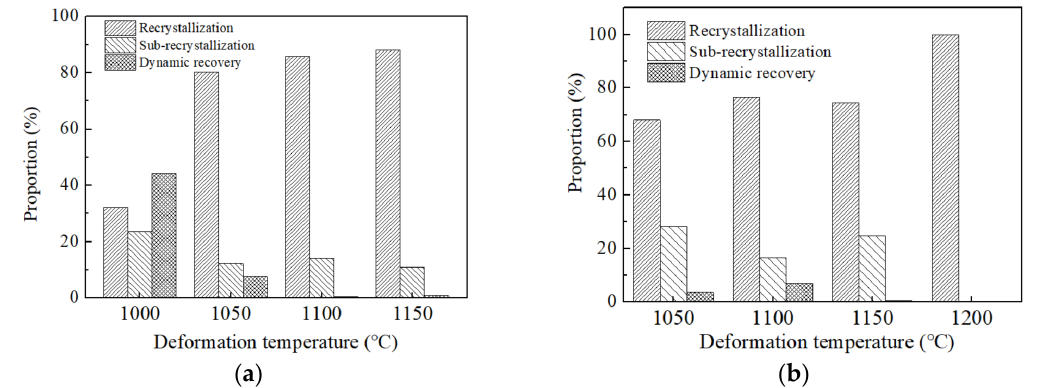
Figure 11. The proportion of recrystallization of two alloys deformed at 1000–1200 °C and 1 s − 1 . ( a ) 2W; ( b ) 4W.